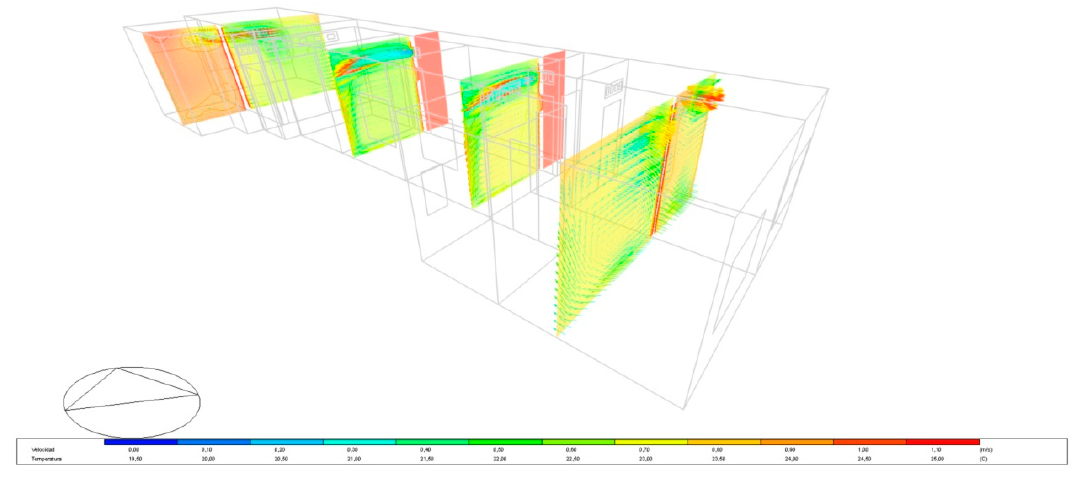
Figure 27. The all-air system in several sections; 1 February 2015, 4:00 p.m.